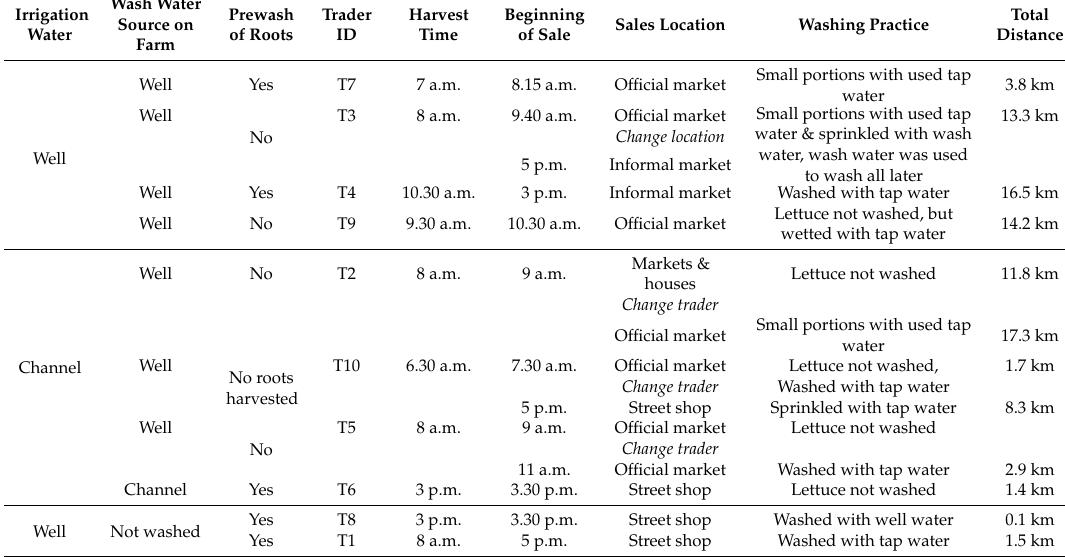
Table 2. Detailed monitoring results about post-harvest handling of 10 lettuce traders from harvest at urban and peri-urban gardens to their sales location in Ouagadougou (Burkina Faso), 2014. Irrigation